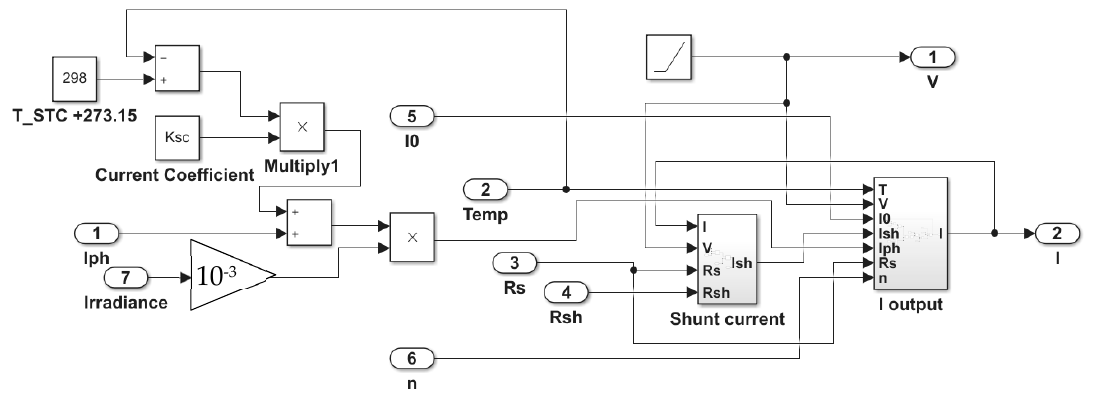
Figure 3. The entire module diagram.